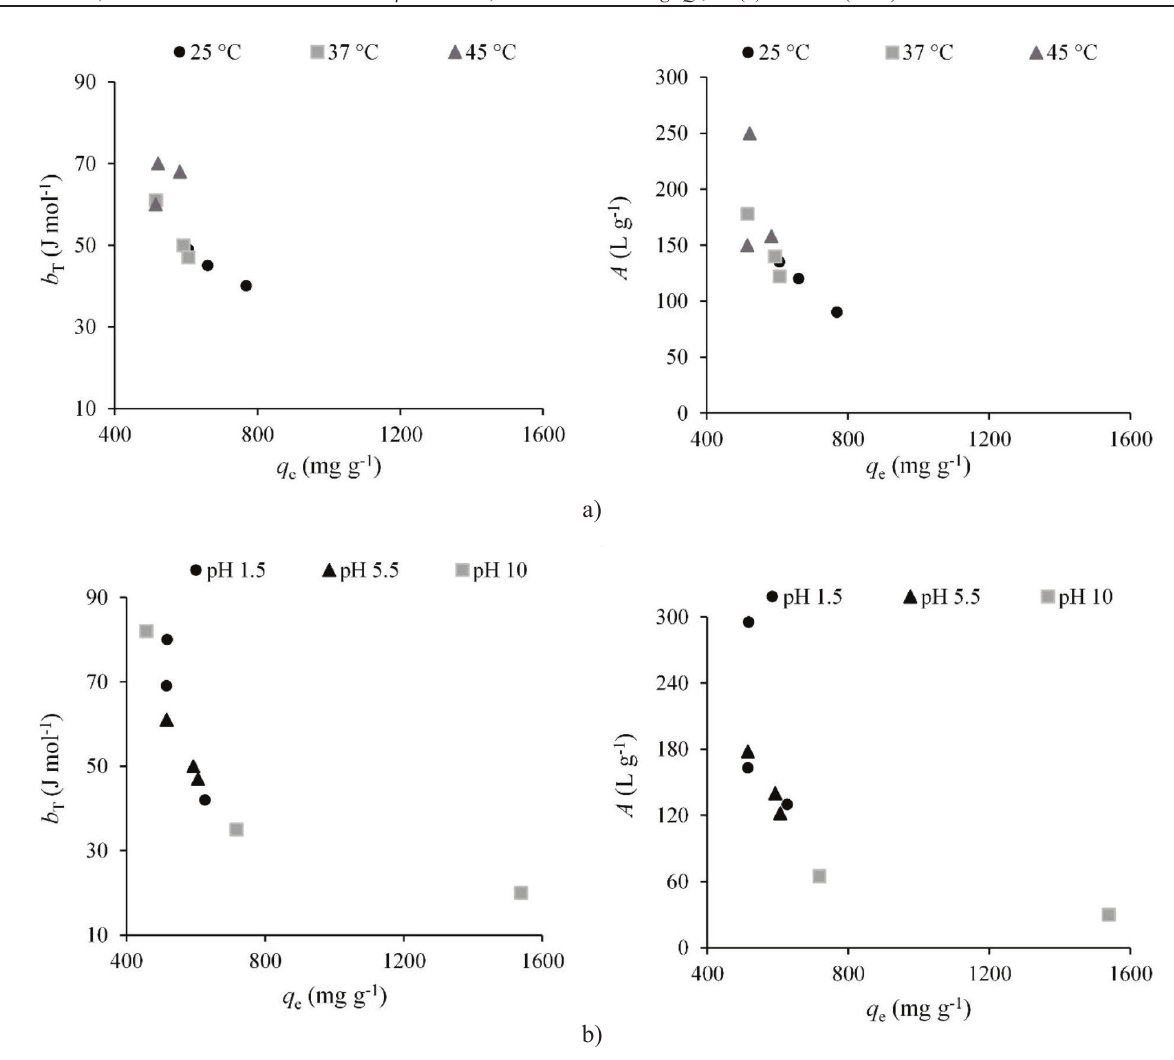
Fig. 4 – Relationship between Temkin adsorption parameters (b b) at different pH values (adsorption capacities obtained in the experiment with the initial concentration of 150 mg L –1 in the reaction solution)